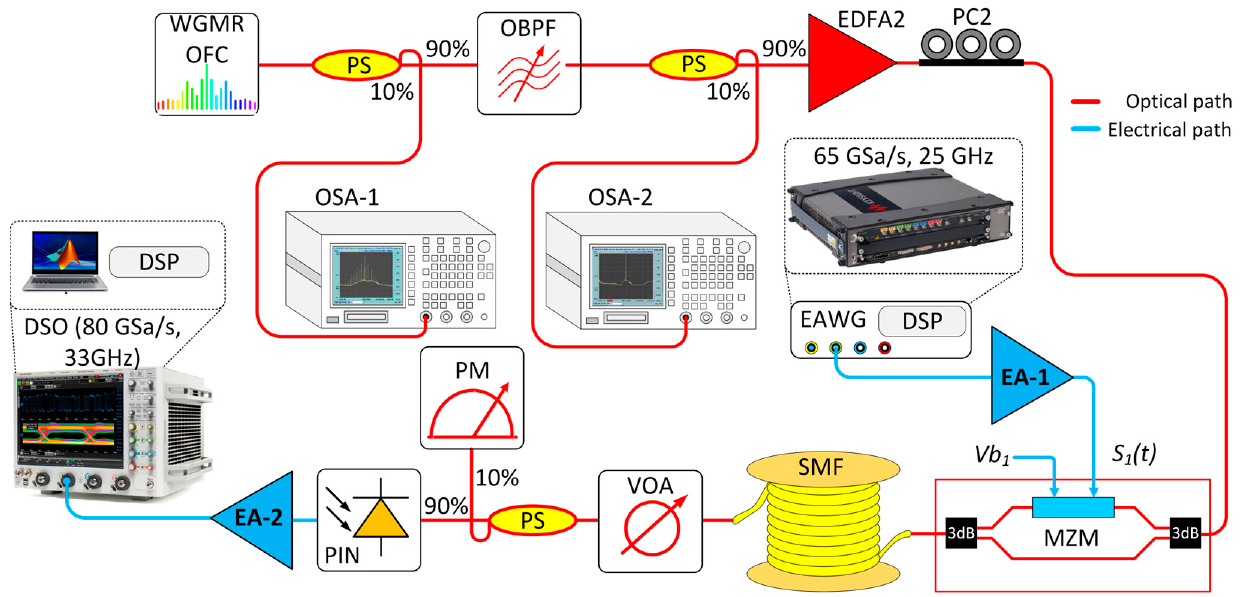
Figure 5. Experimental demonstration of the IM/DD optical interconnect relying on the in-house- built silica microsphere WGMR-based Kerr-OFC as a light source generating 400 GHz spaced optical carriers that are used for up to 50 Gbps/ λ NRZ-OOK modulated signal transmission over a 2 km long SMF link.